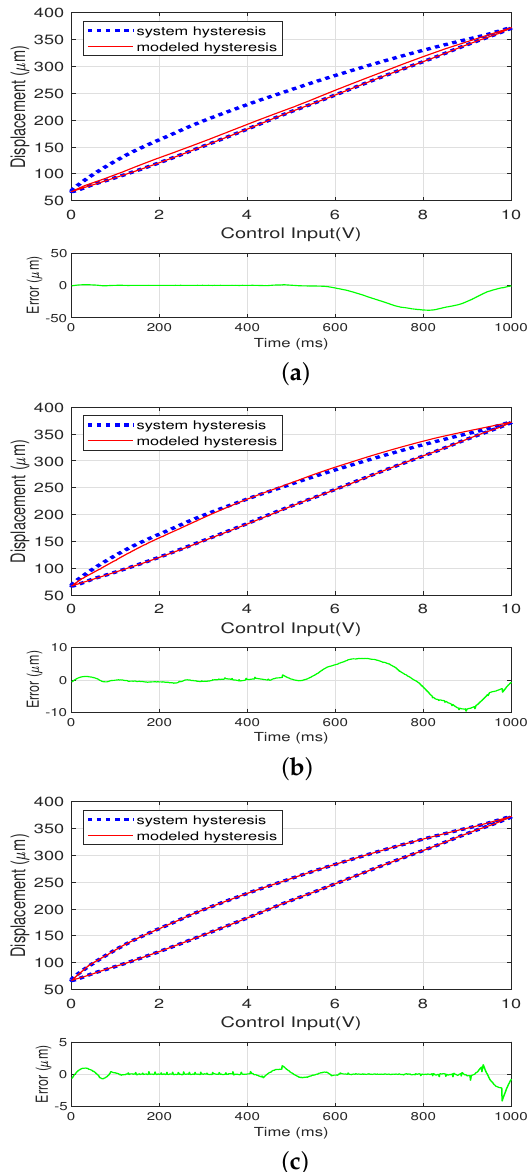
Figure 5. Modeling results for the system hysteresis using the PI, MPI and the DPI model, respectively. ( a ) Modeling results using the PI model. ( b ) Modeling results using the MPI model. ( c ) Modeling results using the DPI